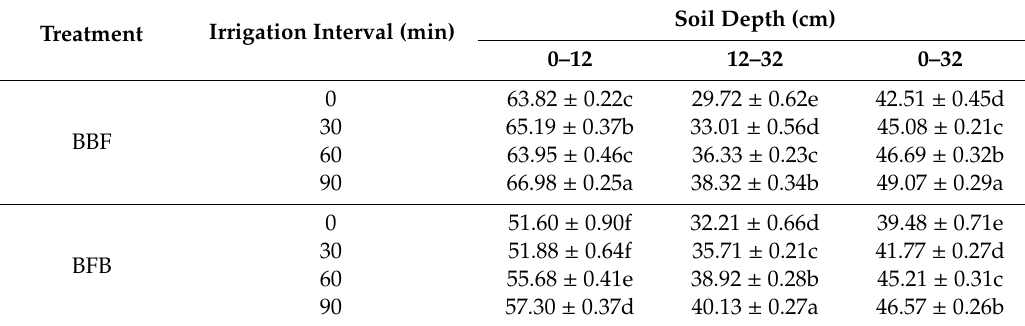
Table 3. Mean desalination rate (%) in the silty loam at depths of 0–32 cm under different irrigation